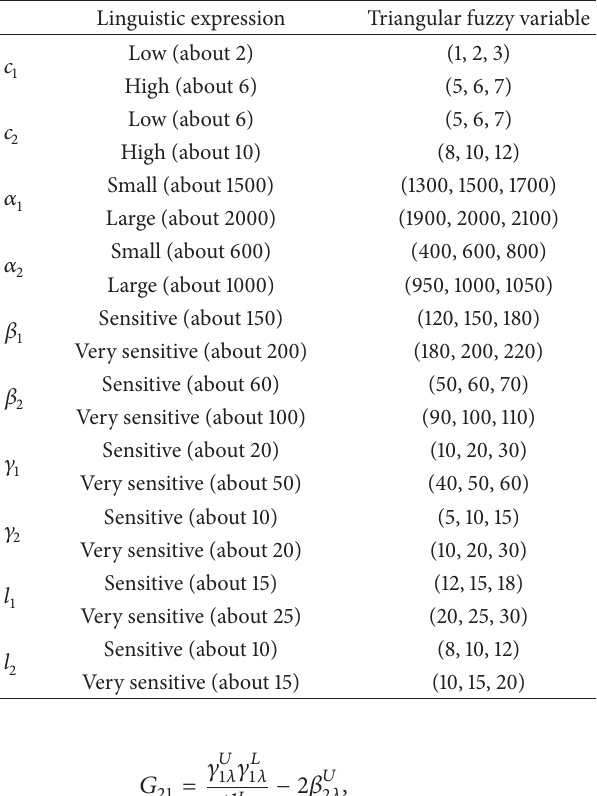
Table2:Relationbetweenlinguisticexpressionandtriangularfuzzy variable.